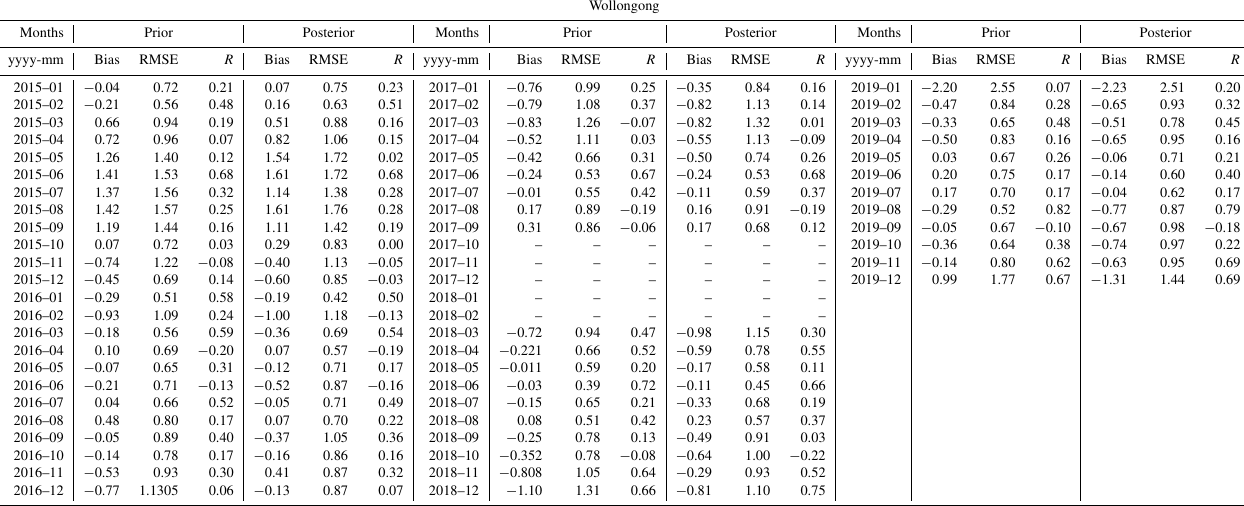
Table F3. Analysis of the residual between CMAQ prior and posterior simulation values and the TCCON Wollongong site for the 2015–2019 period, showing the averaged bias (Bias), root-mean-square error (RMSE), and Pearson coefficient ( R ).